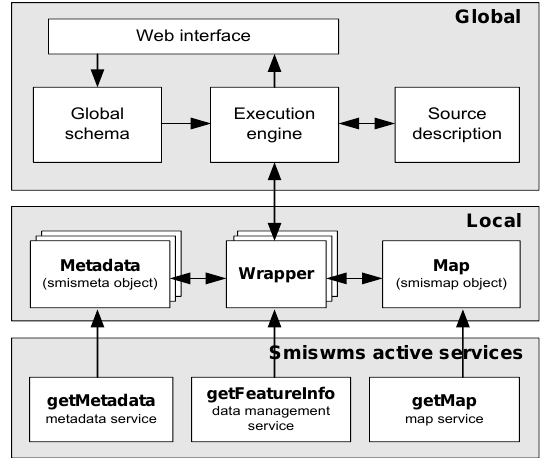
Figure 4. General web-interface architecture, basic